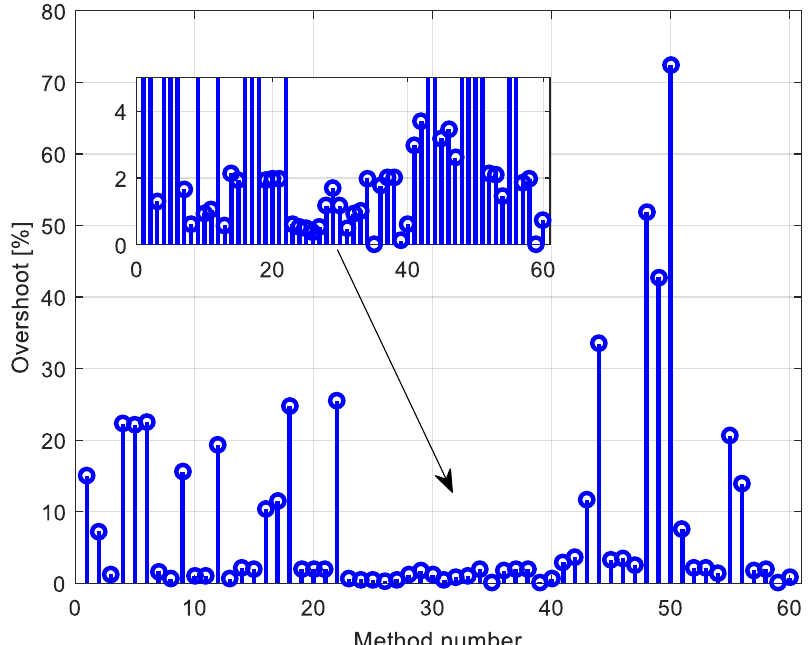
Figure 5. Overshoot of the generator voltage.